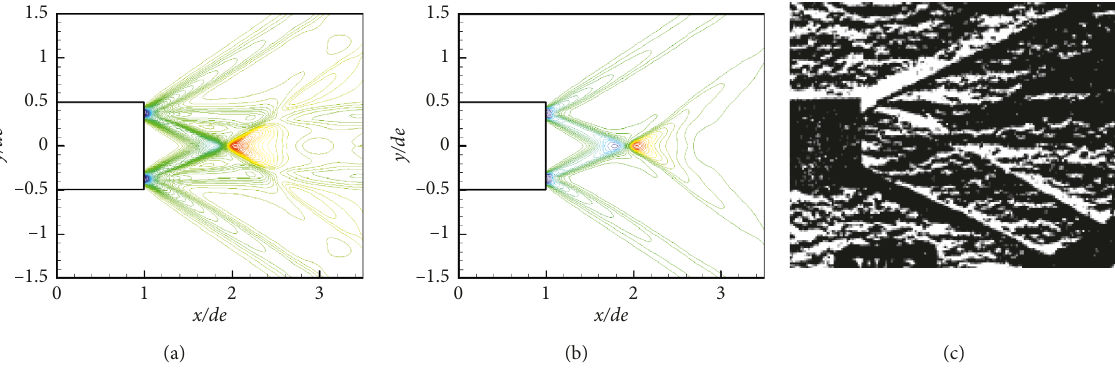
Figure 2: Calculation results of supersonic gas jet field and experimental picture. (a) Density contours. (b) Pressure contours. (c) Ex- perimental picture [21].